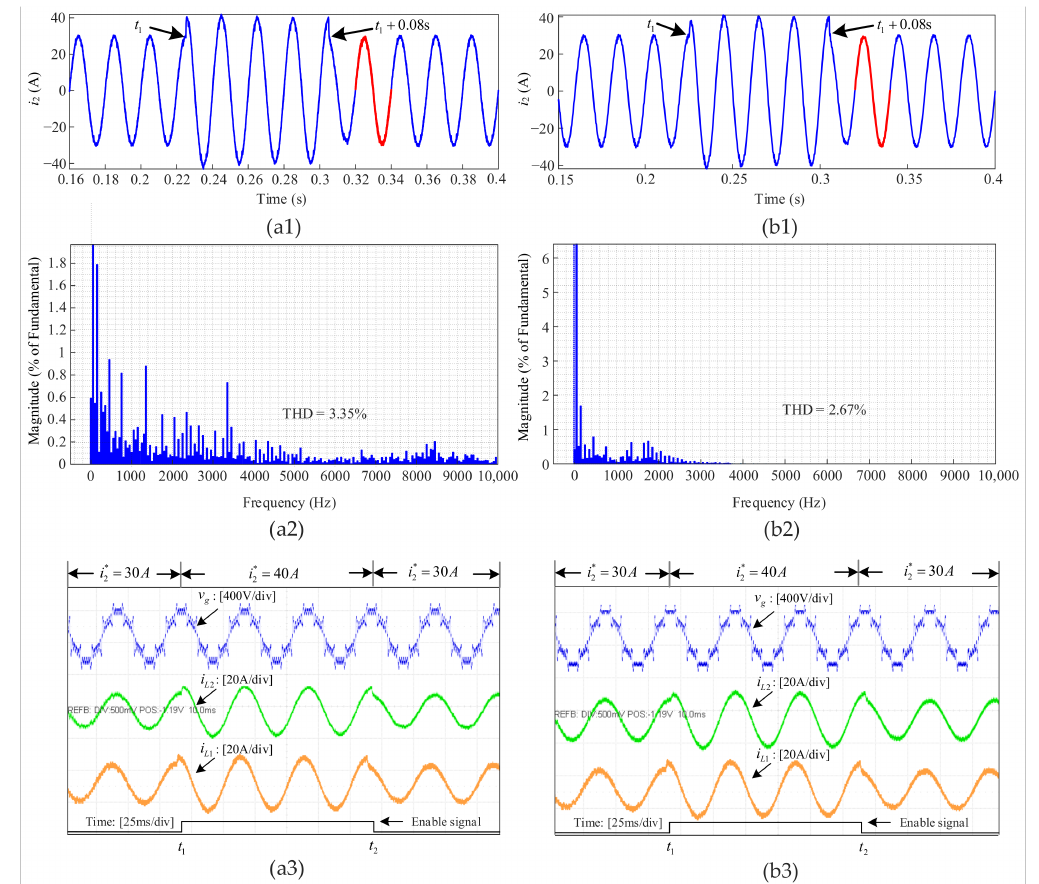
Figure 29. Simulation and experimental results of case 3: ( a1 , a2 ) Simulation results of the grid-side current i L 2 and its FFT analysis for L g = 0; ( b1 , b2 ) simulation results of the grid-side current i L 2 and its FFT analysis for L g = 2.6 mH; ( a3 , b3 ) experimental results of the grid-side current i L 2 and the inverter-side current i L 1 under the distorted grid voltage v g for L g = 0 and L g = 2.6 mH, respectively. For L g = 2.6 mH, the grid voltage contains harmonic components of 6 k ± 1th with an amplitude of 30 V, k = 1, 2, . . . , 6. Correspondingly, the harmonic resonance controllers